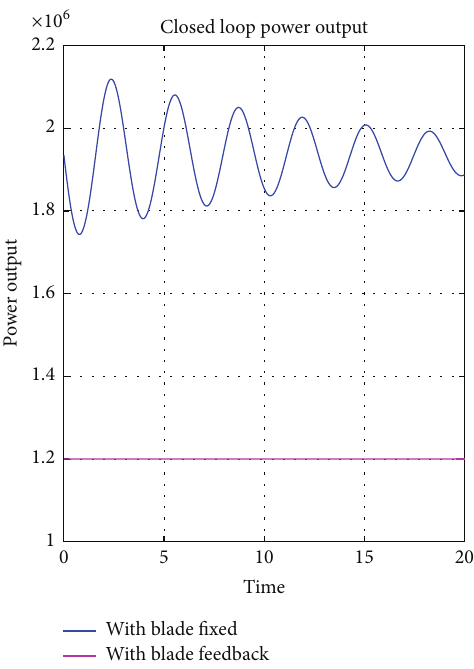
Figure 5: The open and closed loop power output when it is restricted in the closed loop to a prescribed limit.